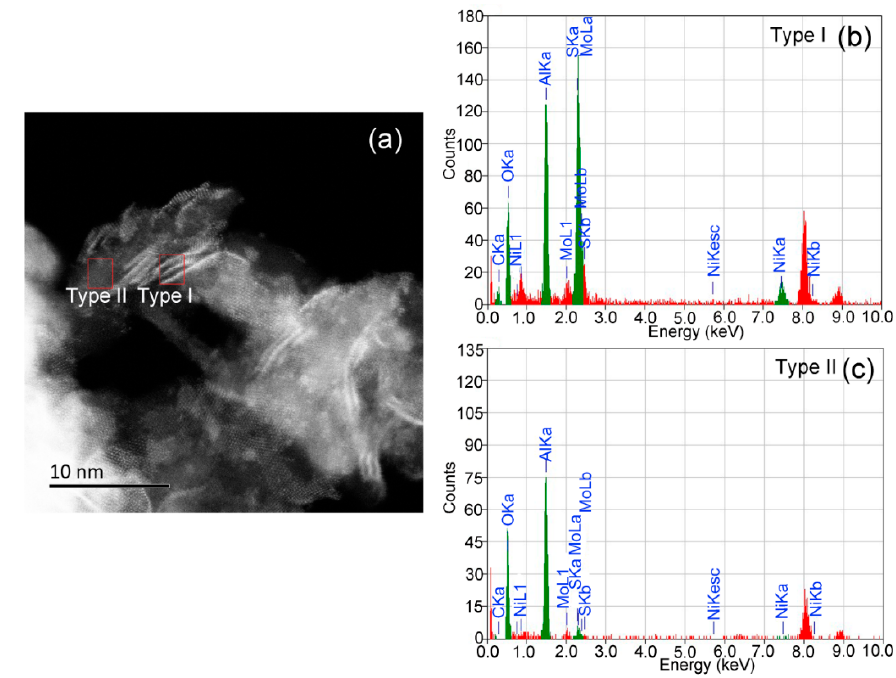
Figure 3. ( a ) Two district types on Cs-STEM-HAADF image of fresh NiMo / γ -Al 2 O 3 catalyst (Cat A), and ( b , c ) corresponding energy dispersive X-ray spectroscopy (EDS)